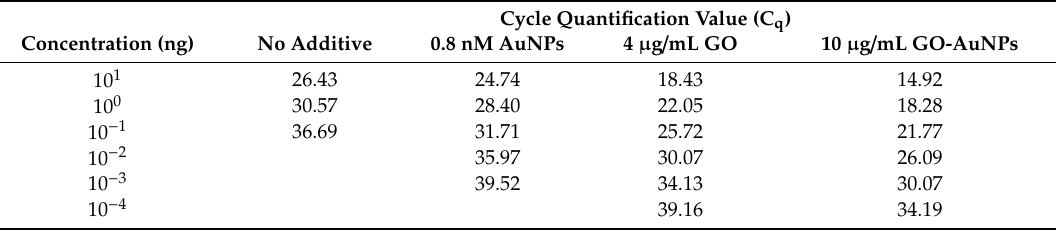
Table 2. Cycle quantitation values (Cq) compared between control and additives including AuNPs, GO, and GO-AuNPs.